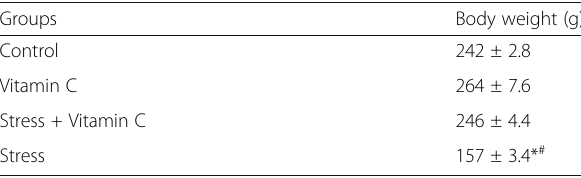
Table 1 Effect of chronic variable stress exposure with vitamin C supplementation on average final body weight Groups